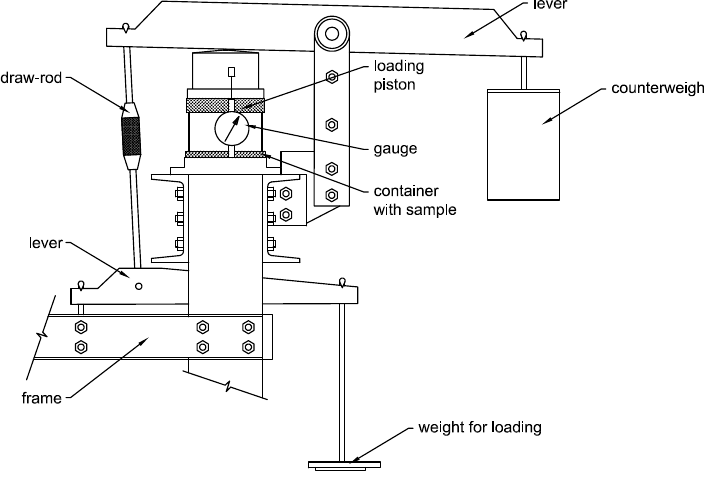
Figure 10. Scheme of the oedometer apparatus.